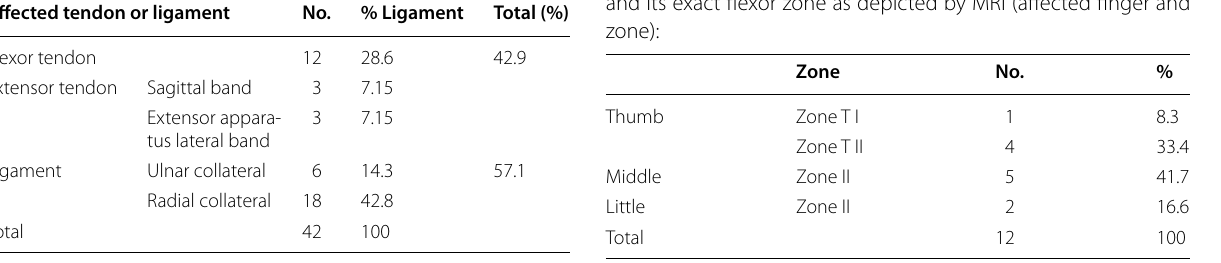
Table 2 Detection of tendon and ligament tears by MRI in patients with history of trauma: Affected tendon or ligament